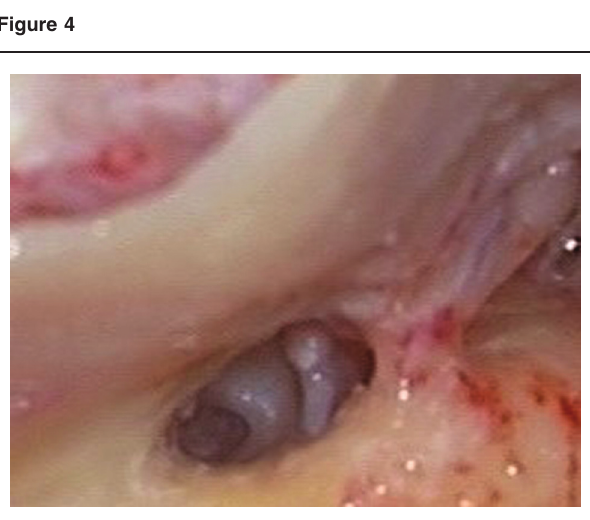
RWM fully visible through RWN. RWM, round window membrane; RWN, round window niche. Figure 4